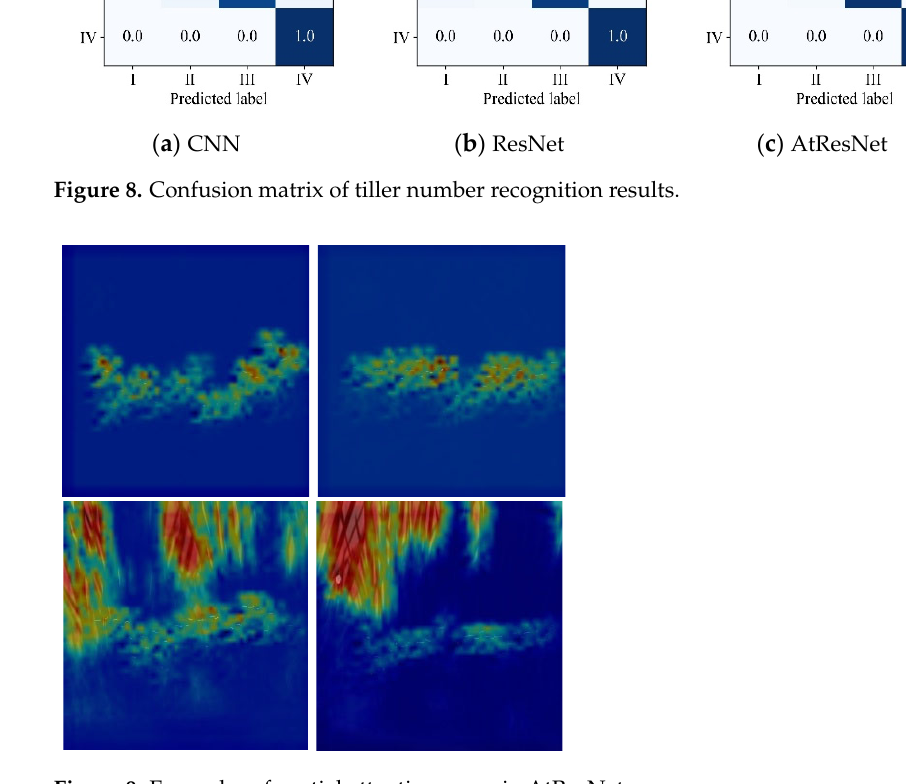
Figure 9. Examples of spatial attention maps in AtResNet.